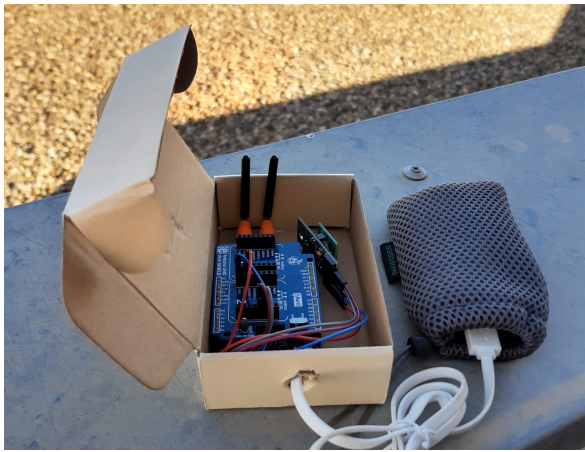
Figure 3. AirCrowd devices of